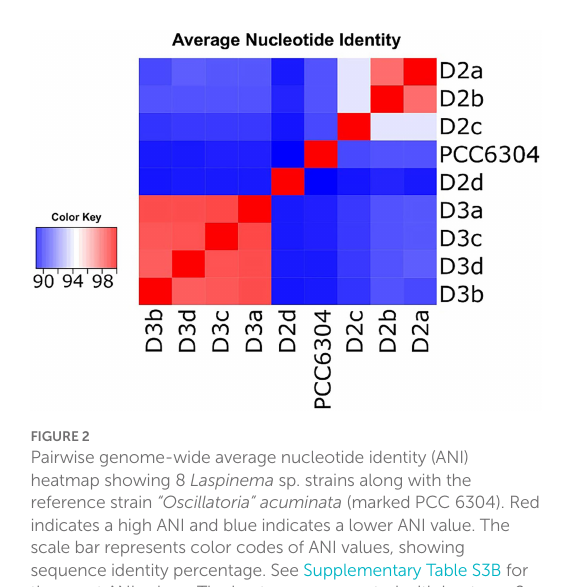
FIGURE 2 Pairwise genome-wide average nucleotide identity (ANI) heatmap showing 8 Laspinema sp. strains along with the reference strain “Oscillatoria” acuminata (marked PCC 6304). Red indicates a high ANI and blue indicates a lower ANI value. The scale bar represents color codes of ANI values, showing sequence identity percentage. See Supplementary Table S3B for the exact ANI values. The heatmap was created with heatmap.2 function within ‘gplots’ (Warnes et al., 2016) package in R.